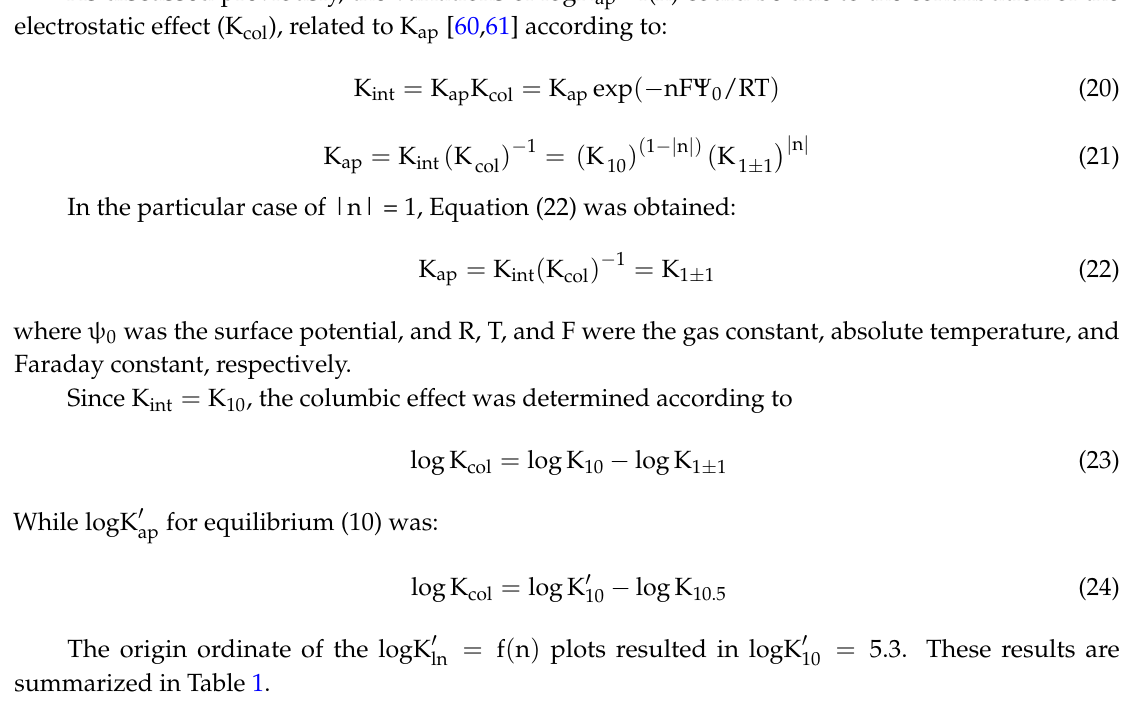
Table 1. Surface complexation constants for Cr (VI) sorption onto Octacalcium phosphate. Species n Adsorption Reaction logK